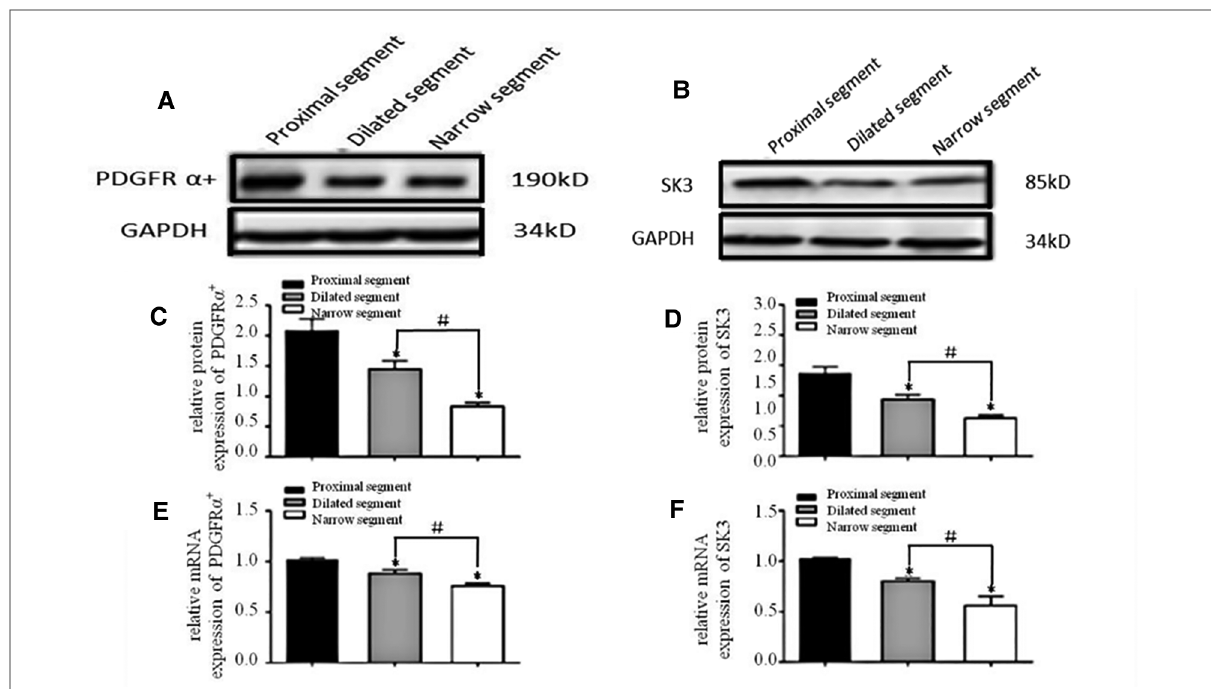
FIGURE 2 mRNA and protein expressions of PDGFR α and SK3. ( A,B ): Electrophoresis identi fi cation. ( C,D ): Signi fi cant difference among the relative expressions of proteins in the three segments (narrow, dilated, and proximal). ( E,F ): mRNA expressions of PDGFR α and SK3 in the three segments. * P <0.05 vs. proximal segment; # P <0.05 dilated vs. narrow segments.